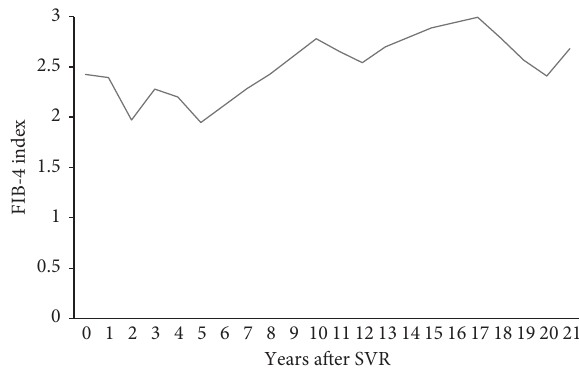
Figure 3: Time course of fibrosis-4 (FIB-4) index levels from SVR achievement to